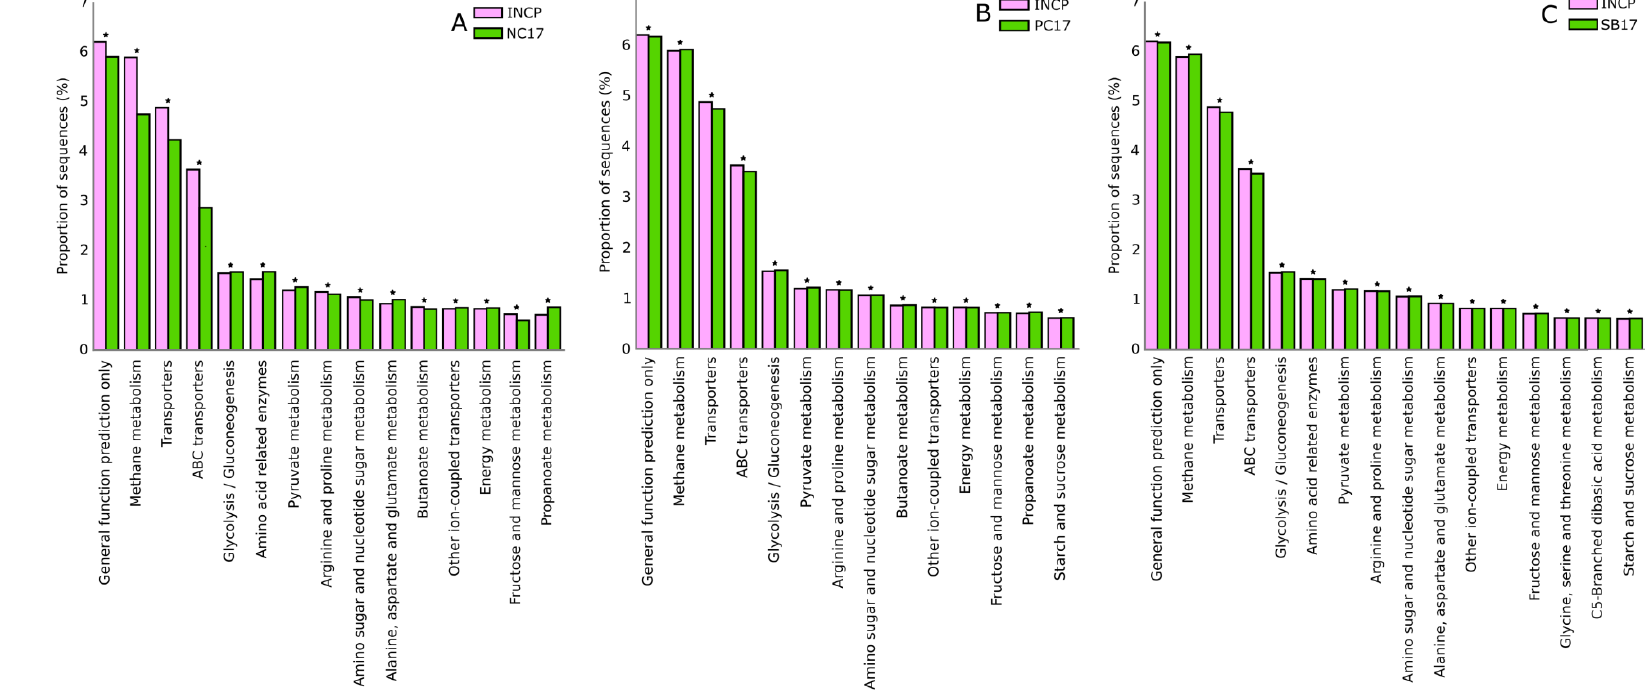
Figure 7. Prediction of metabolic pathways in the archaea. This figure shows the predicted metabolic pathway between: ( A ) The inoculum (INCP) and negative control at the 17th day (NC17); ( B ) inoculum (INCP) and positive control at the 17th day (PC17); ( C ) inoculum (INCP) and substrate at the 17th day (SB17). The x-axis shows the predicted metabolic pathways; the y-axis indicates the proportion of sequences as a percentage (%). The star (*) represents the statistical difference between samples with at least p < 0.05, and q < 0.05 using Benjamini-Hochberg correction.